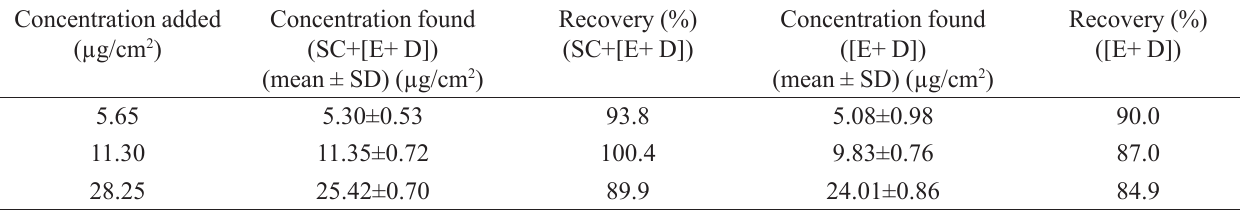
TABLE I - Recovery of quercetin extracted from different skin layers Concentration added